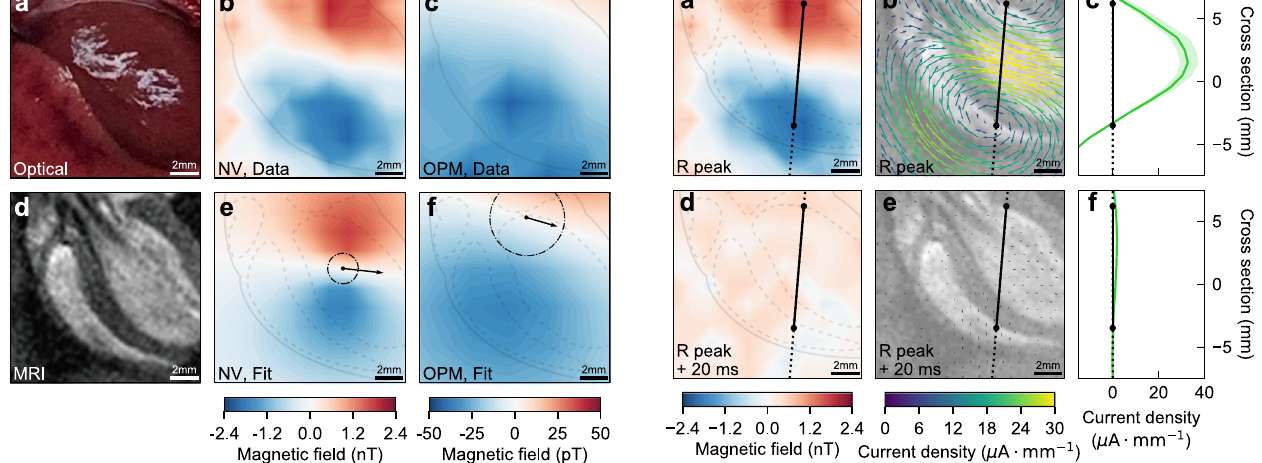
Fig. 4d – f presents the measured magnetic fi eld pattern, calculated current density distribution, and current density across the linecut, evaluated at 20 ms after the R-wave peak. As expected, almost no signal was present, resulting in a total current of I NV